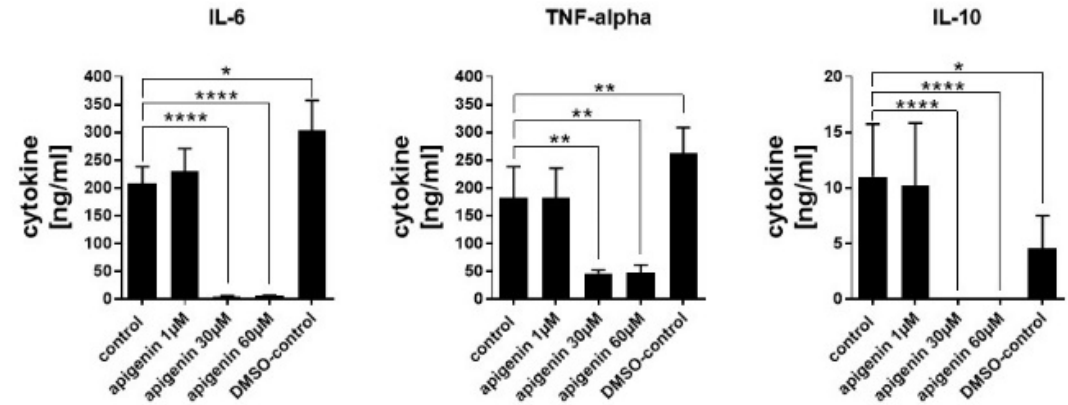
Figure 10. Quantification of cytokines in the supernatant of human dendritic cells stimulated with vehicle, Api in different concentrations or DMSO for 24 h in presence of LPS. Data are expressed as mean ± standard deviation (SD), significant differences are indicated as * p < 0.05; ** p < 0.01; **** p < 0.0001; n = 3.